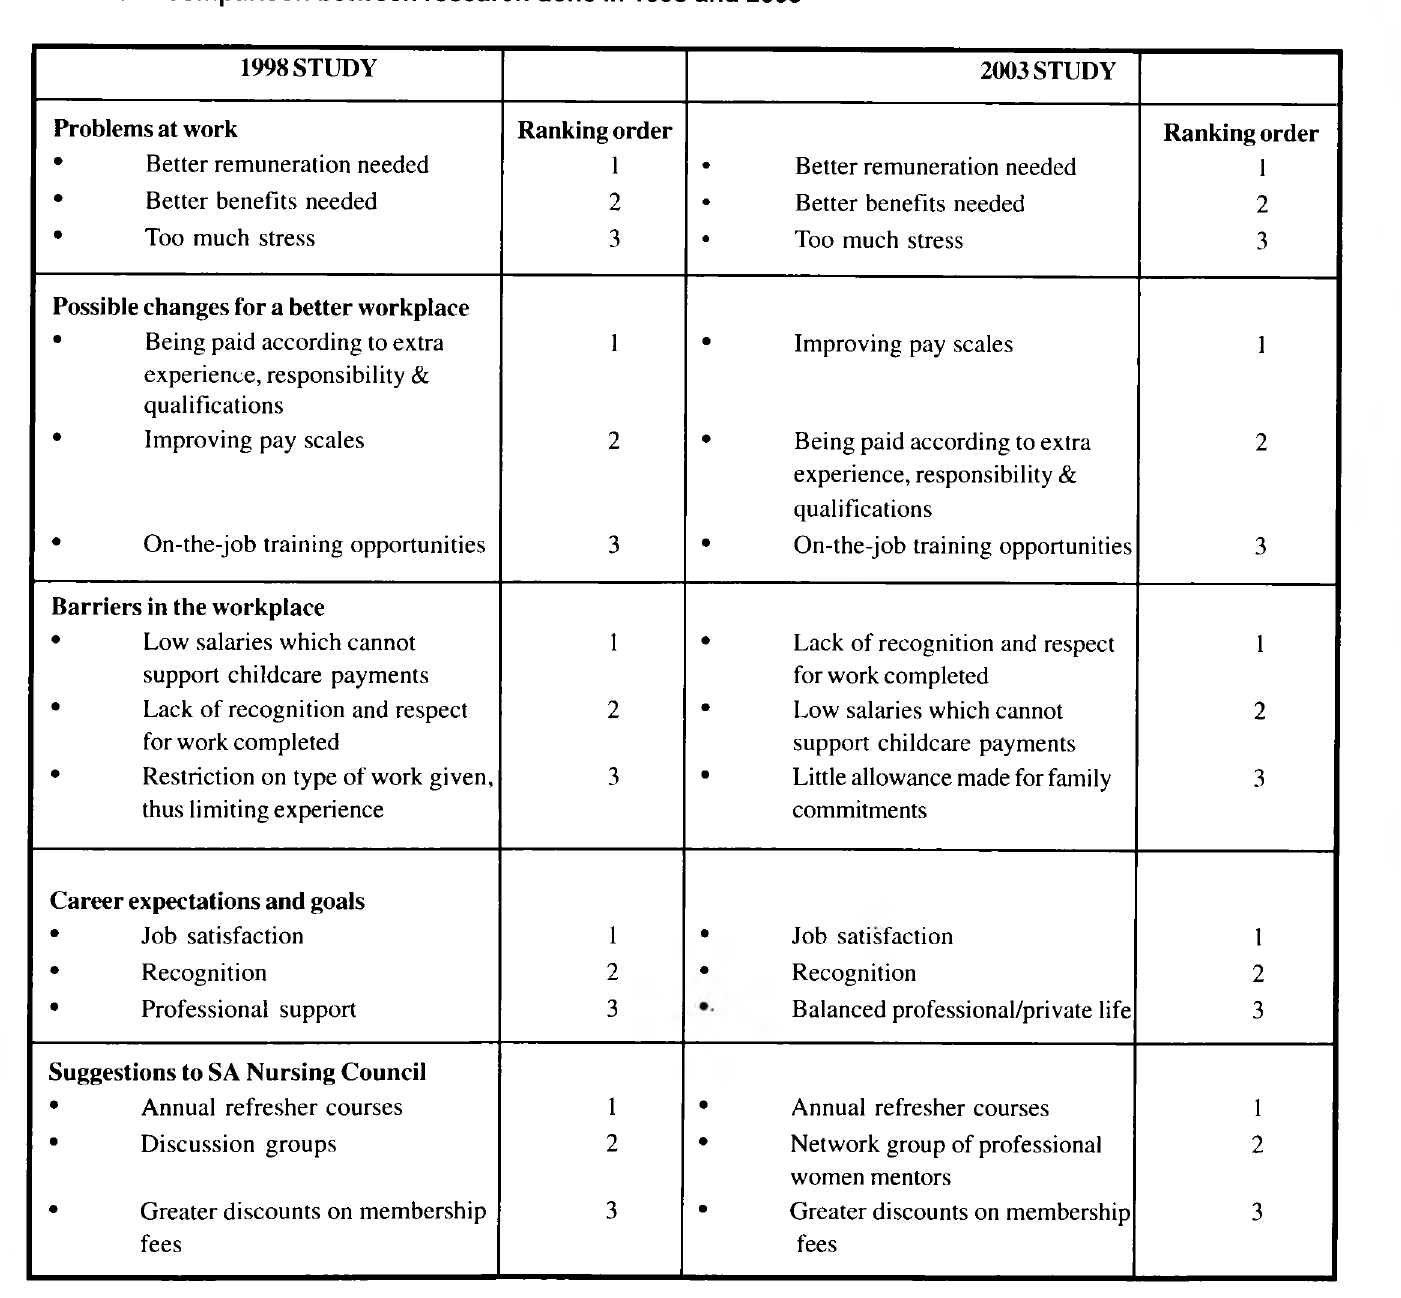
Table 10 A comparison between research done in 1998 and